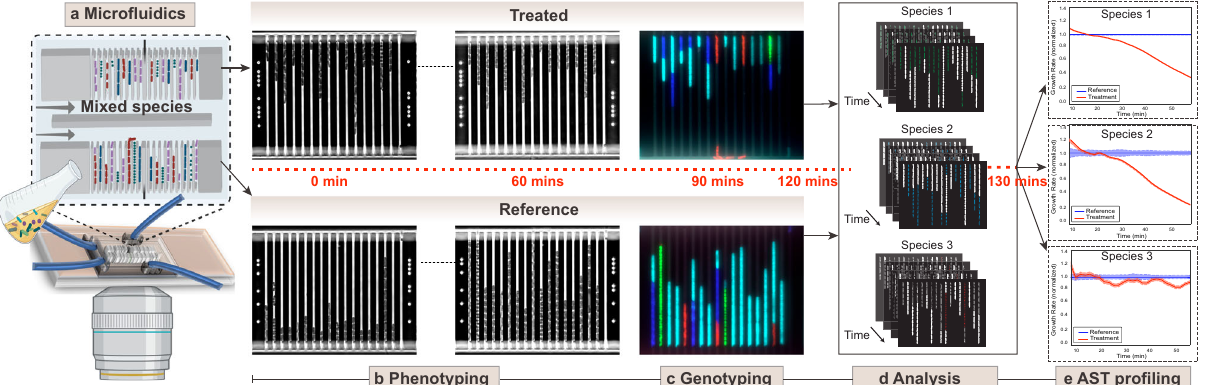
Fig.1|SchematicrepresentationoftheASTwork fl owwithtimeline.a Acartoon of the micro fl uidicssetup with the mixed speciesloaded onthe chip. b Time-lapse phase-contrast imagesofthecellsinthe traps when growninmediawith(top)and without (bottom) antibiotics. c Fluorescence images of the bacteria with ssDNA